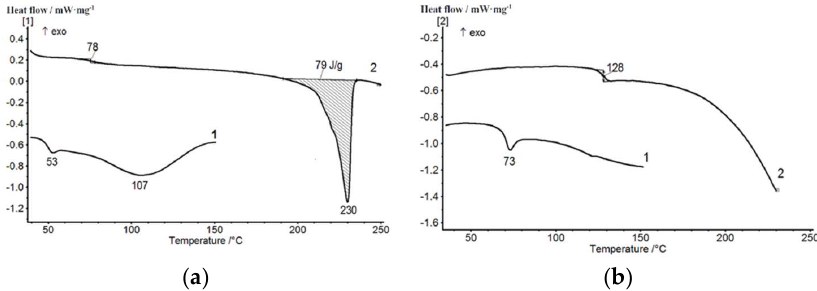
Figure 5. DSC curves of the first and second scans of PVA ( a ) and PAA ( b ) samples.